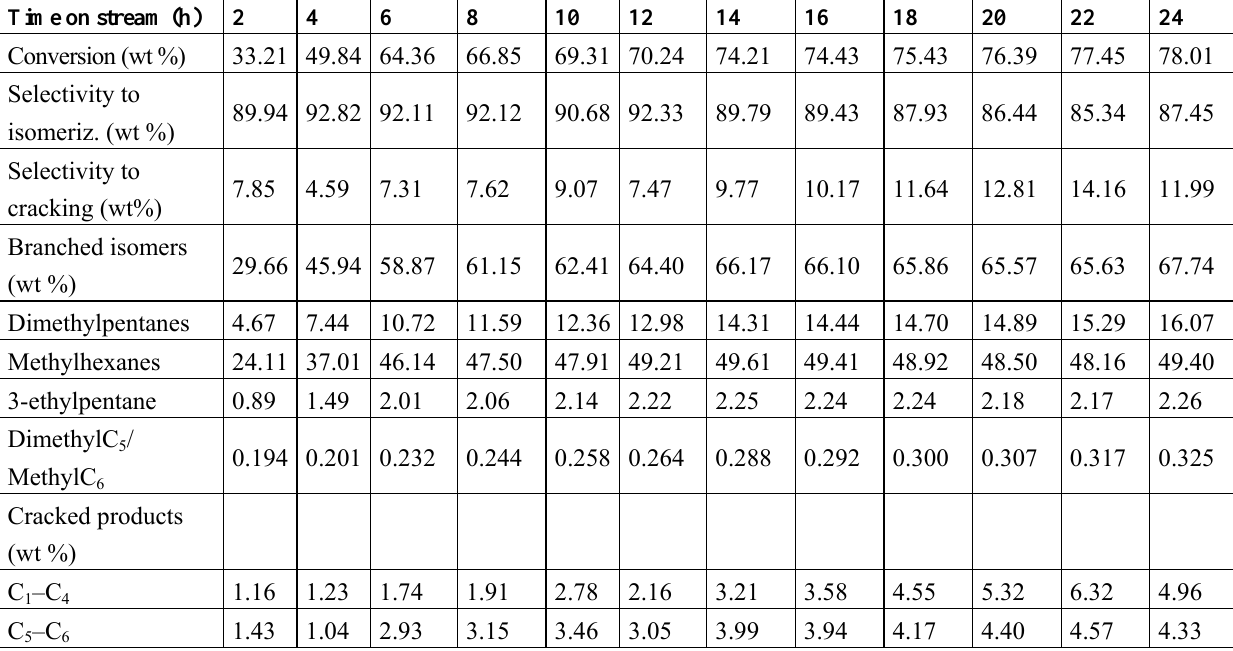
Table 4. Isomerization of n -heptane over molybdenum sub-oxides catalyst (643 K, 18.5 bar). Time on stream (h)